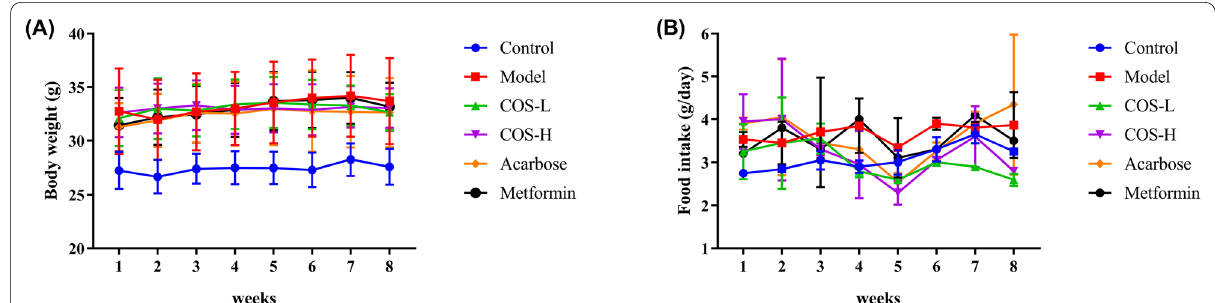
Fig. 3 Changes in the A body weight and B food intake during the intervention process